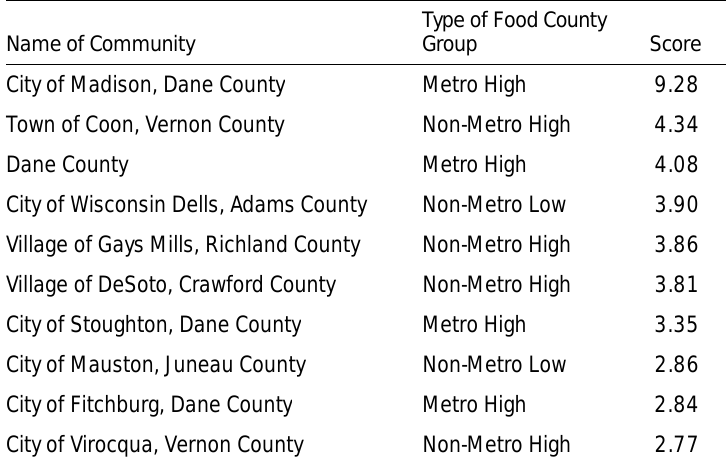
Table 3. Top Ten Scores by Community and Group Name of Community